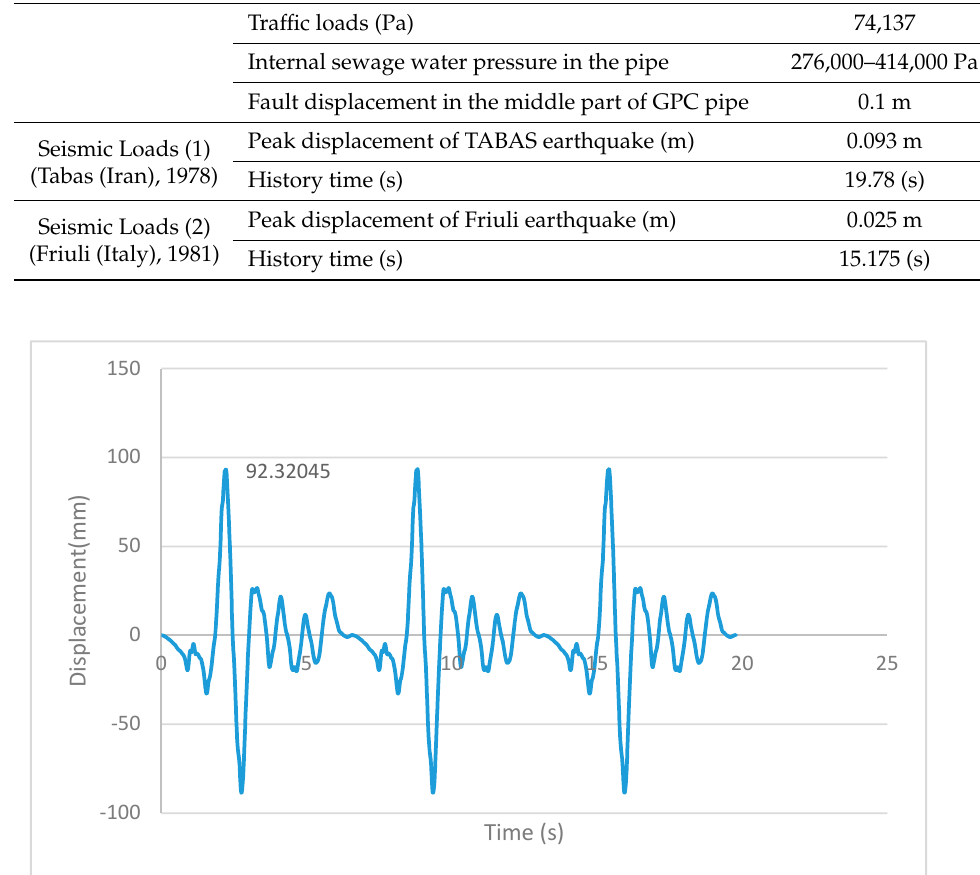
Figure 10. The X-displacement series of the Tabas earthquake, Iran 1978 (Peer Ground Motion Database [43]).